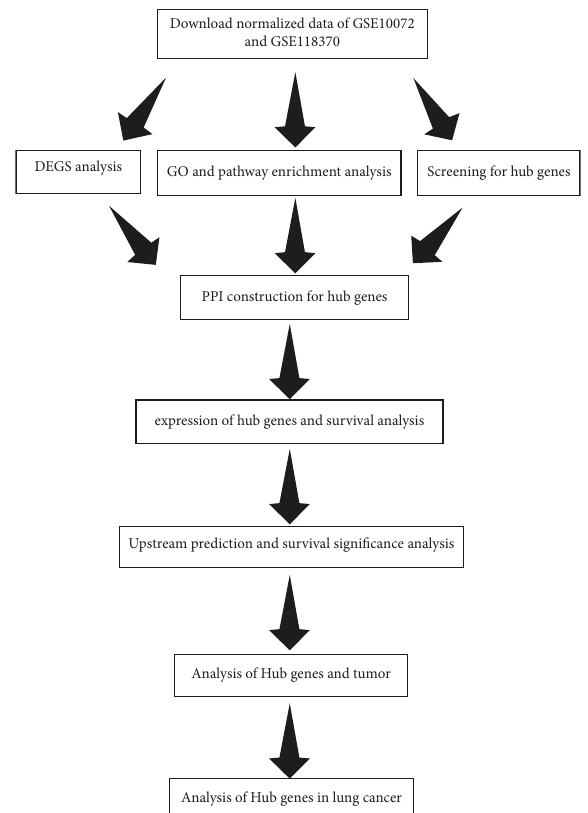
Figure 1: Flow chart of data preparation, processing, analysis, and